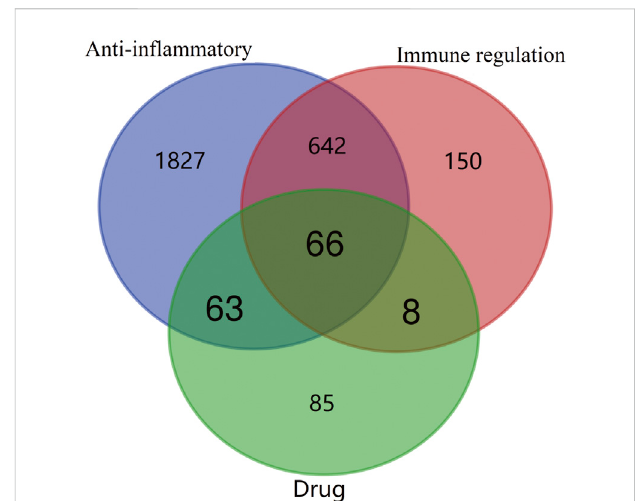
FIGURE 4 Venn diagram of drug (bioactive peptide) and disease intersection